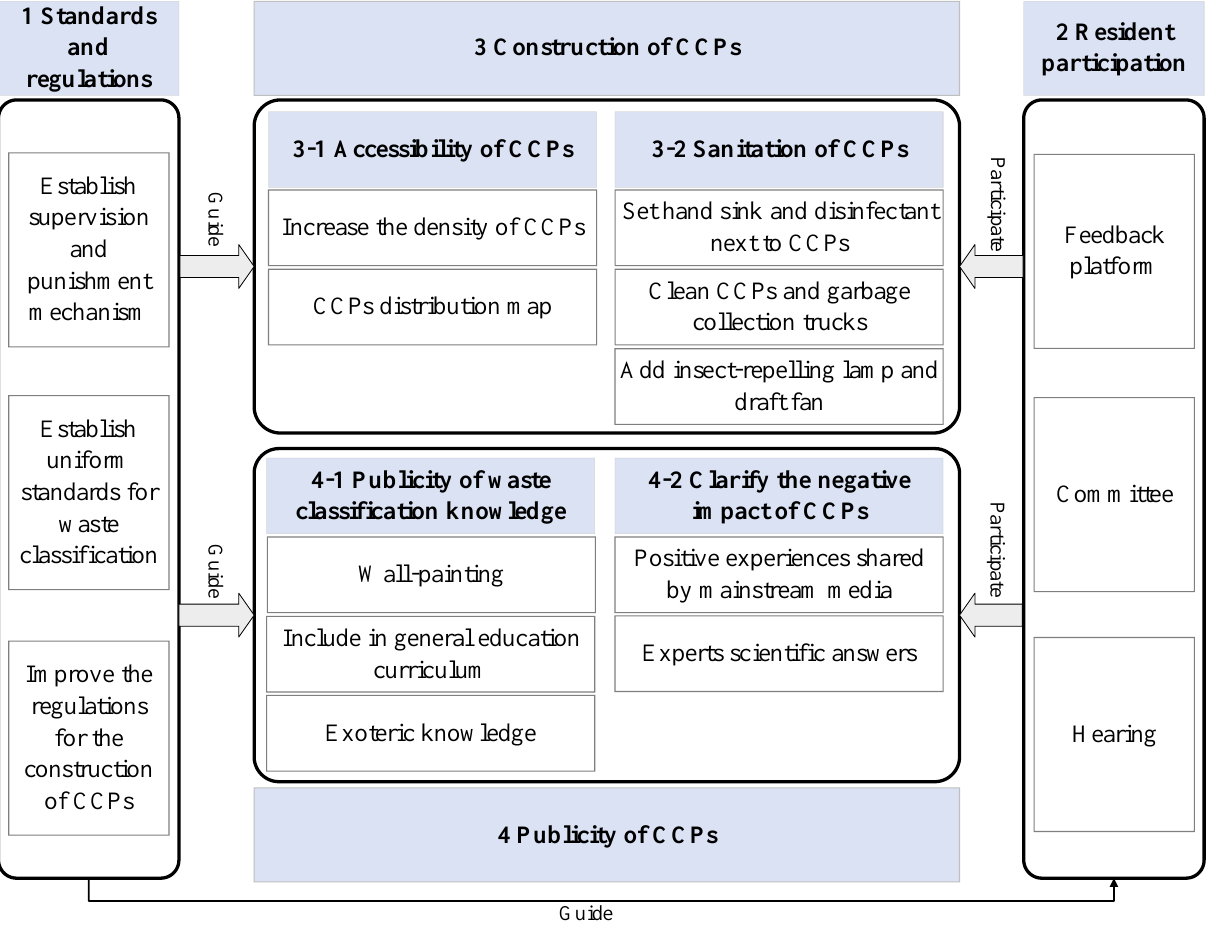
Figure 4. Strategies for promoting residents’ behavioral willingness.